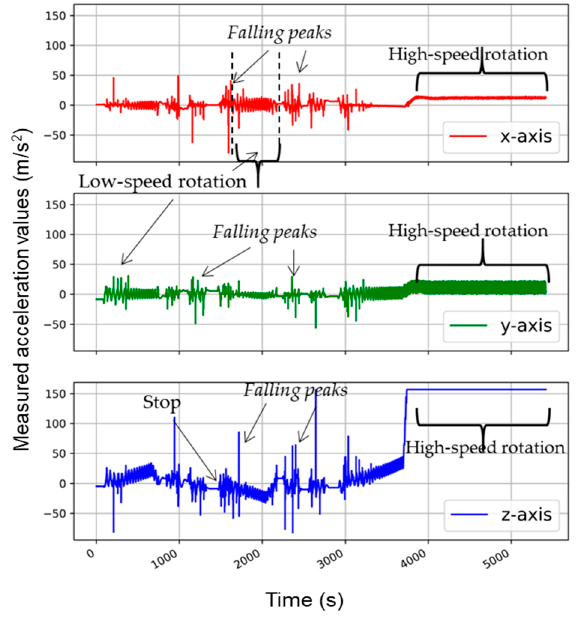
Figure 7. Accelerometer analysis in the tumbling phase at 400 RPM (revolutions per minute).